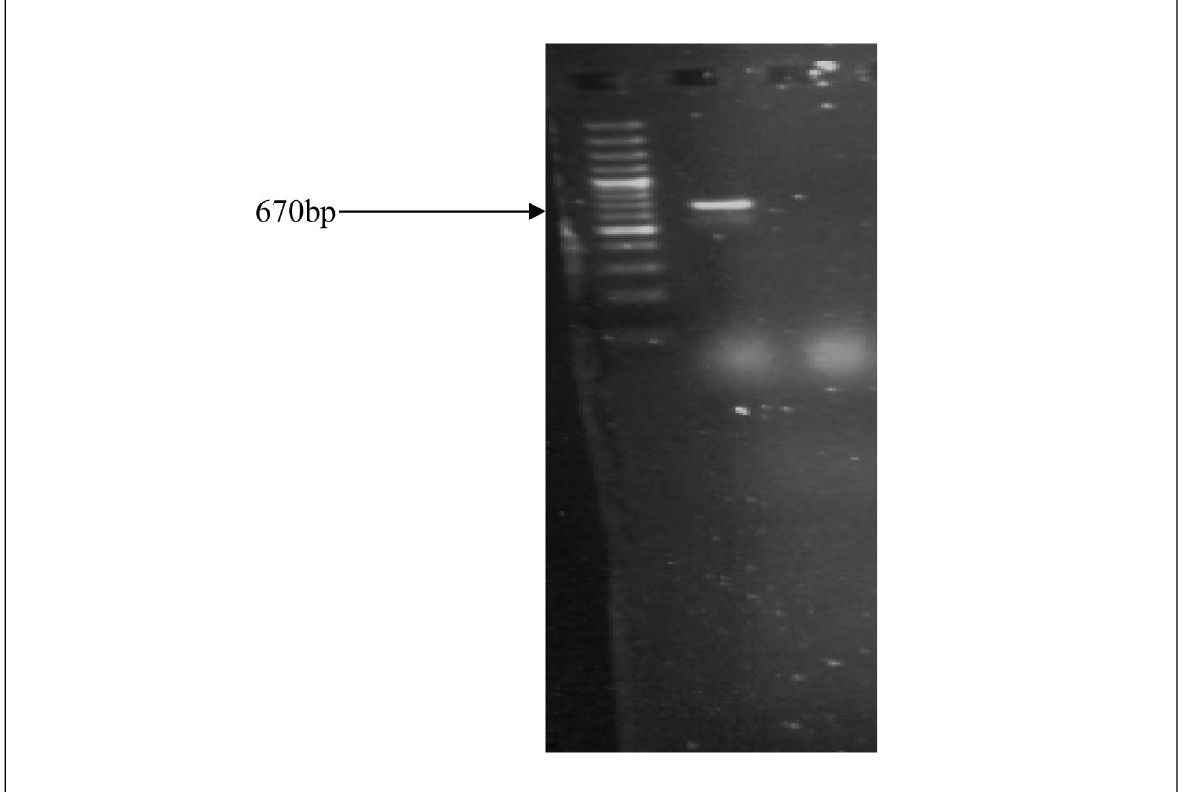
Figure 4: Isolates possessing aadA gene confirming resistance to sparfloxacin